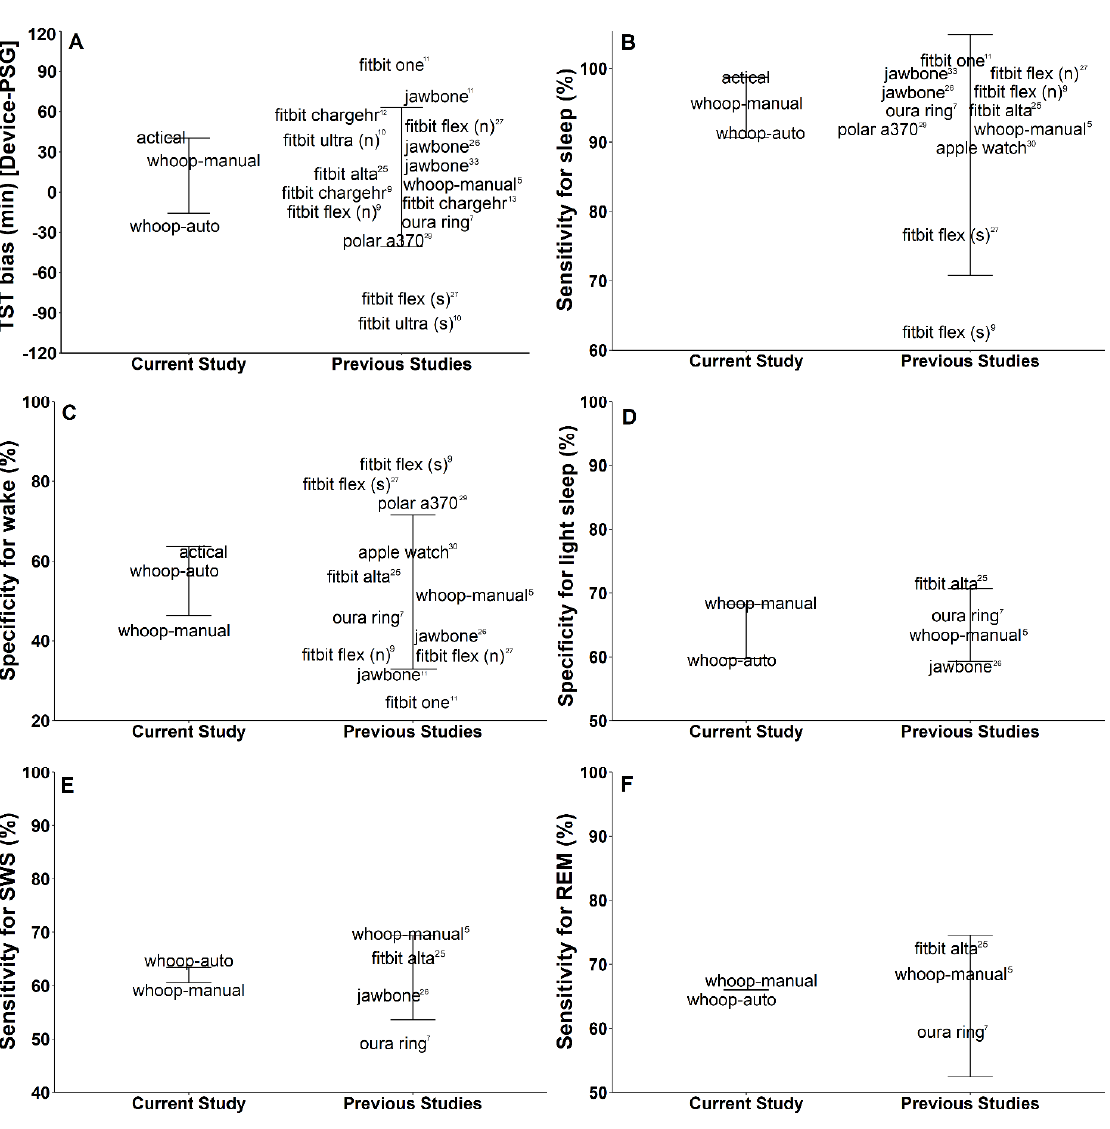
Figure 5. Performance of ACTICAL, WHOOP-AUTO, WHOOP-MANUAL and other sleep wearables for ( A ) total sleep time bias (TST), ( B ) sensitivity for sleep, ( C ) specificity for wake, ( D ) sensitivity for light sleep, ( E ) sensitivity for slow wave sleep (SWS) and ( F ) sensitivity for rapid eye movement sleep (REM). Error bars represent standard deviation. Fitbit Flex (N); Fitbit Flex with normal sensitivity, Fitbit Flex (S); Fitbit Flex with high sensitivity. Superscript numbers represent respective validation studies [5,7,9–12,25–31].